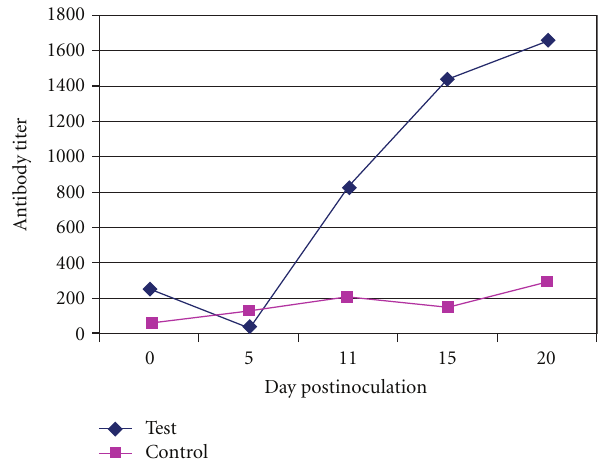
Figure 3: Representative graph of ELISA antibody titer against IBV of test and control